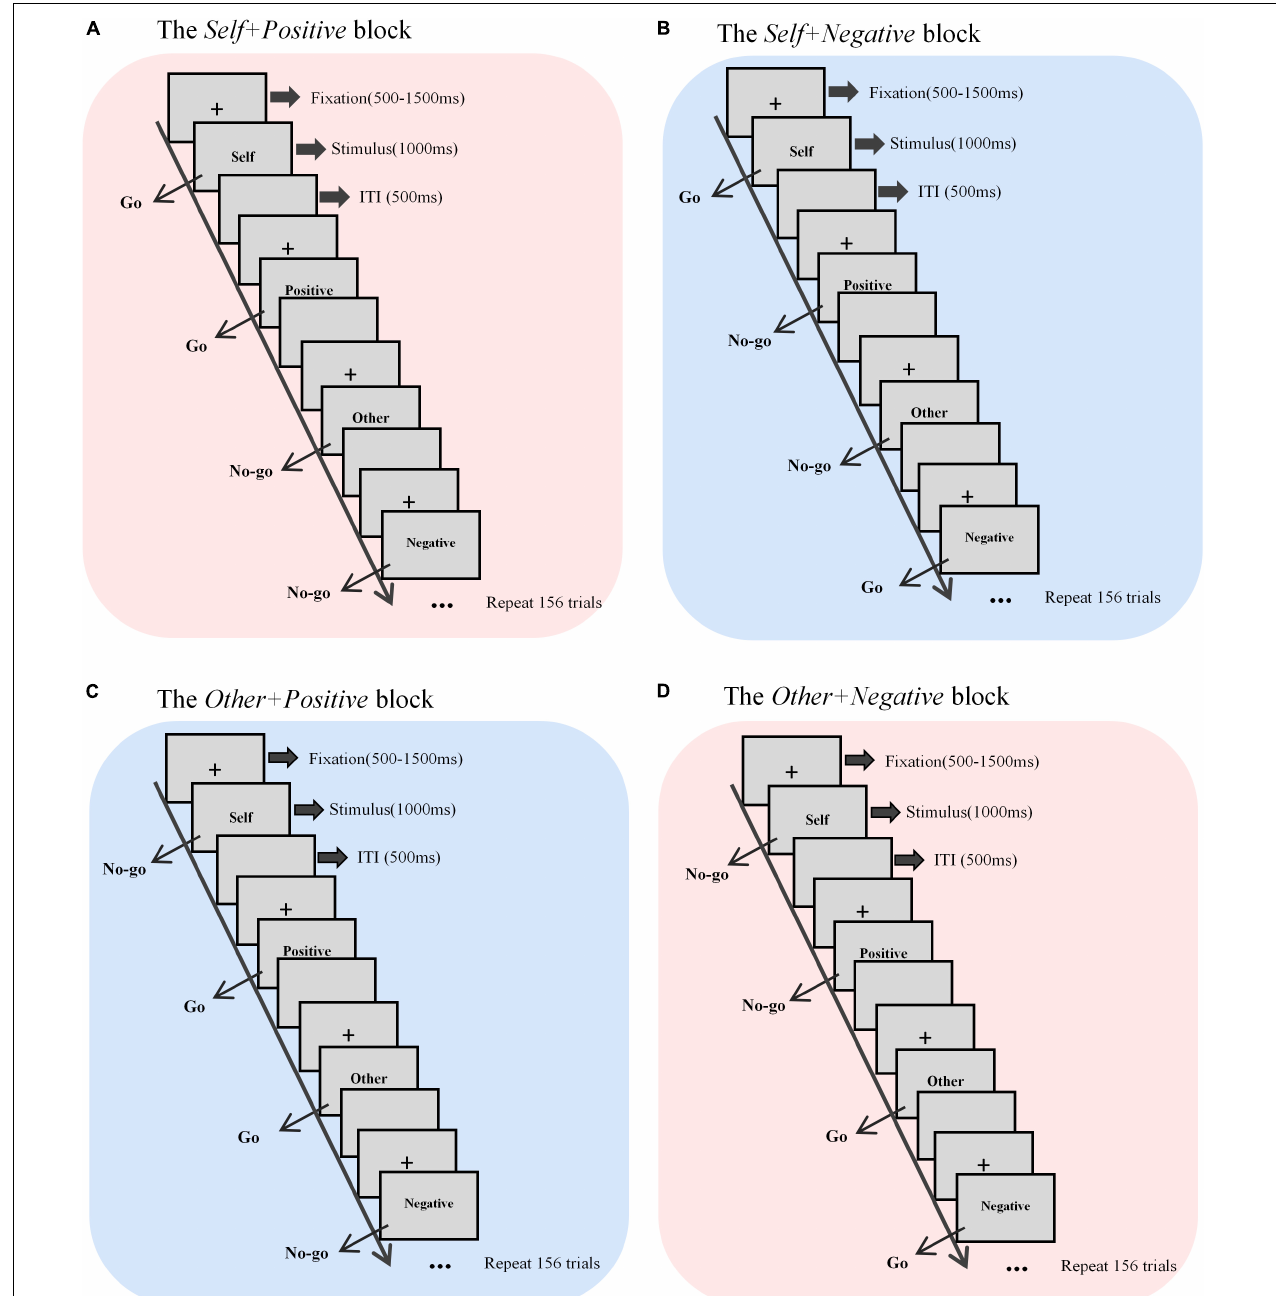
FIGURE 1 | Sketch map of the self-esteem GNAT process. There were four blocks with different target stimuli, that is, (A) self + positive , (B) self + negative , (C) other + positive , and (D) other + negative . Each block contained 160 trials. ITI, inter-trial interval.